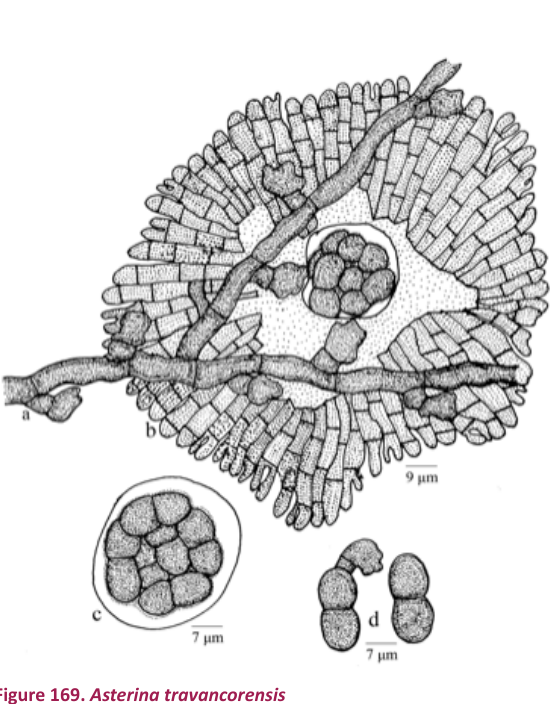
Figure 169. Asterina travancorensis a.Appressorium, b. Thyriothecium, c. Ascus, d.